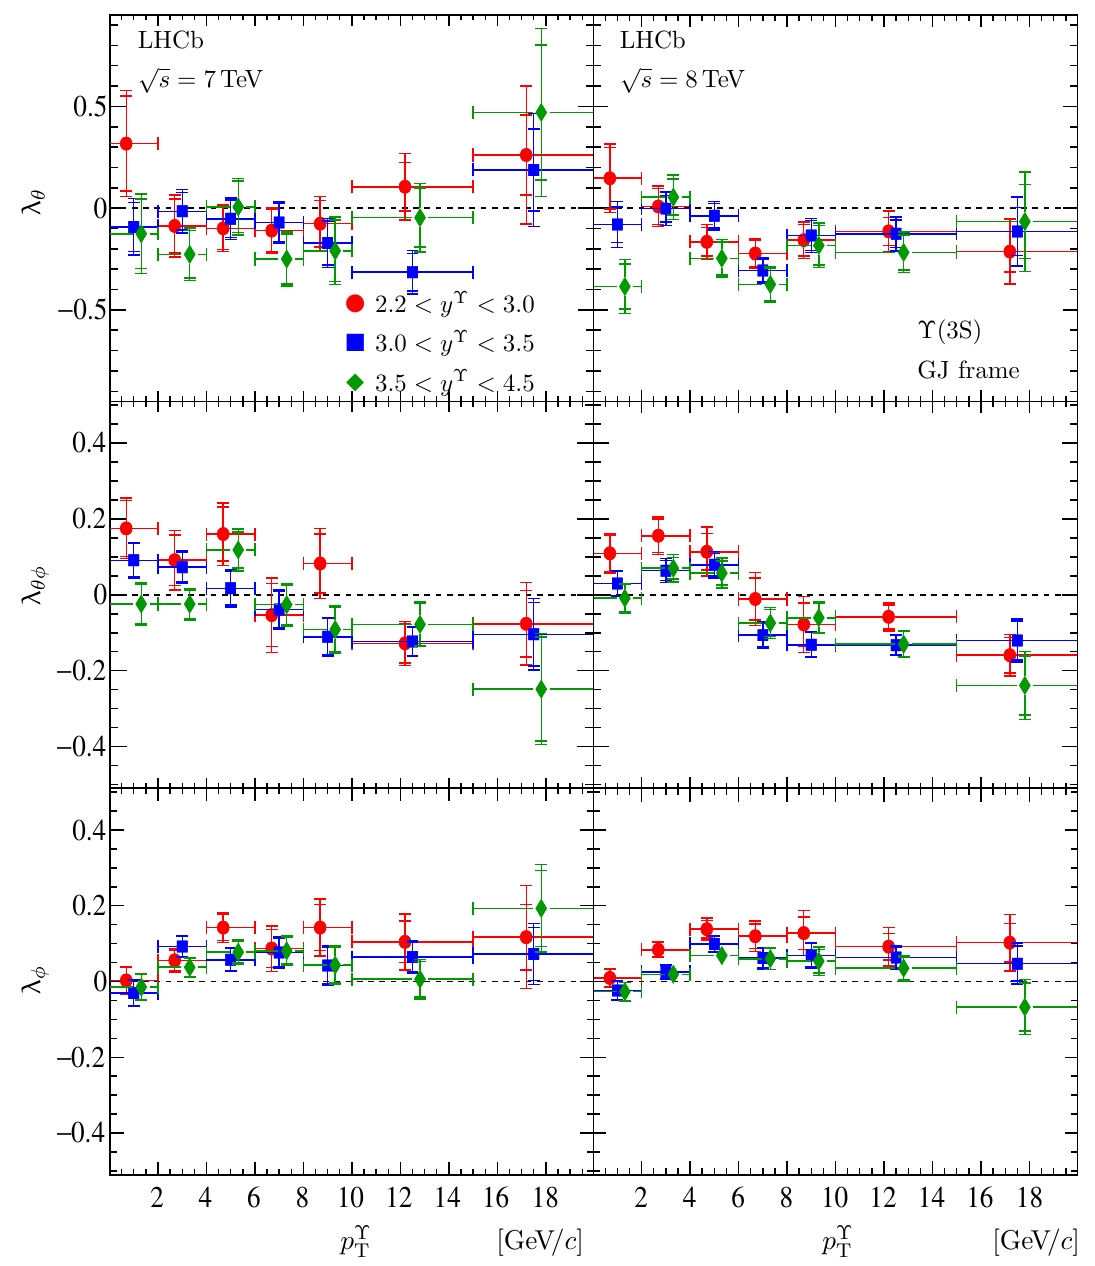
Figure 11 . The polarization parameters (cid:21) (cid:18) (top), (cid:21) (cid:18)(cid:30) (middle) and (cid:21) (cid:30) (bottom), measured in the GJ frame for the (cid:7)(3S) state in di(cid:11)erent bins of p (cid:7) and three rapidity ranges, for data collected T p p at s = 7 TeV (left) and s = 8 TeV (right). The results for the rapidity ranges 2 : 2 < y (cid:7) < 3 : 0, 3 : 0 < y (cid:7) < 3 : 5 and 3 : 5 < y (cid:7) < 4 : 5 are shown with red circles, blue squares and green diamonds, respectively. The vertical inner error bars indicate the statistical uncertainty, whilst the outer error bars indicate the sum of the statistical and systematic uncertainties added in quadrature. The horizontal error bars indicate the bin width. Some data points are displaced from the bin centers to improve visibility.